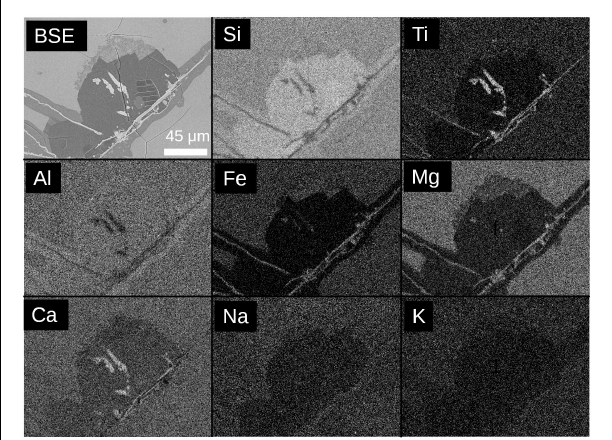
FIGURE 7 | Compositional microanalysis of a representative region including backscattered electron (BSE) and energy-dispersive X-ray spectrometry (indicated elements, K-alpha lines). Titanite-mineralized tubules exposed on the section surface are visible as Ca- and Ti-rich regions within the zeolitic host (Si-rich, Fe-poor), and surrounded by basaltic glass (Mg- and- Fe-rich, lower Si than zeolite). Scale bar identical in each image. Scale identical in each image. Optical and additional BSE images of this region are also shown in Figure 6 .